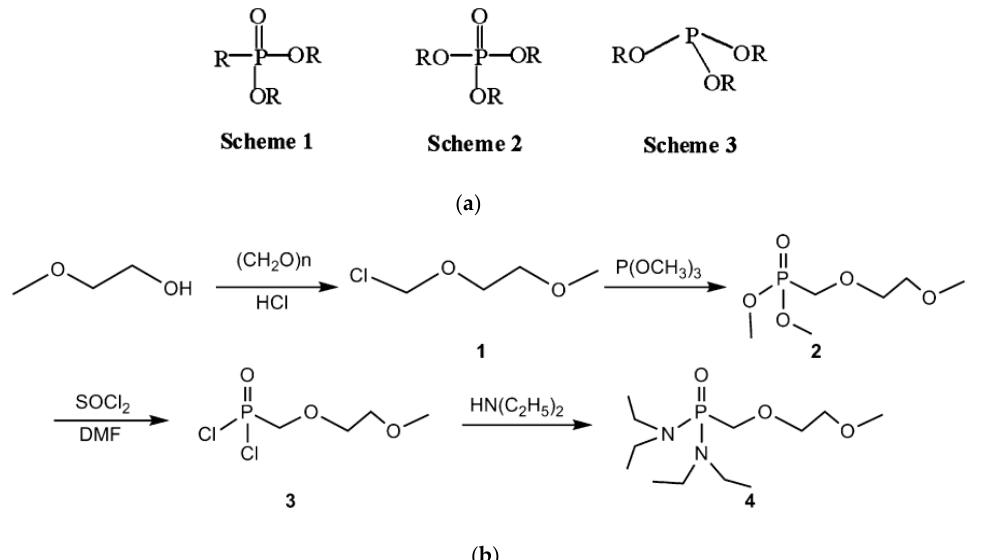
Figure 11. ( a ) Schemes for the three kinds of phosphorus. Adopted from Ref. [206]; ( b ) The synthetic route of DEMEMPA. Adopted from Ref. [207].